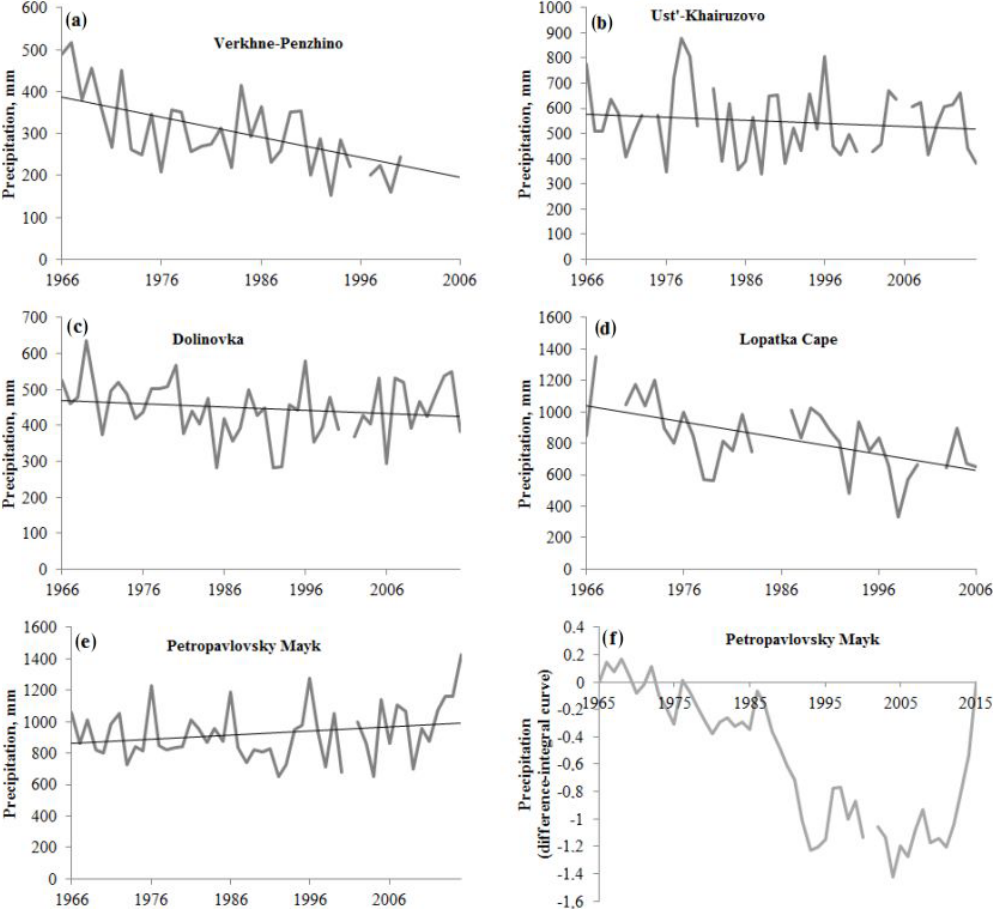
Figure 3. Trends in precipitation change in the northern (continental) part (Verkhne-Penzhino station, a ), western coast (Ust’-Khairuzovo station, b ), central part (Dolinovka station, c ), the very south of the peninsula (Lopatka Cape station, d ), and eastern coast (Petropavlovky Mayk station, e, f ) in the Kamchatsky